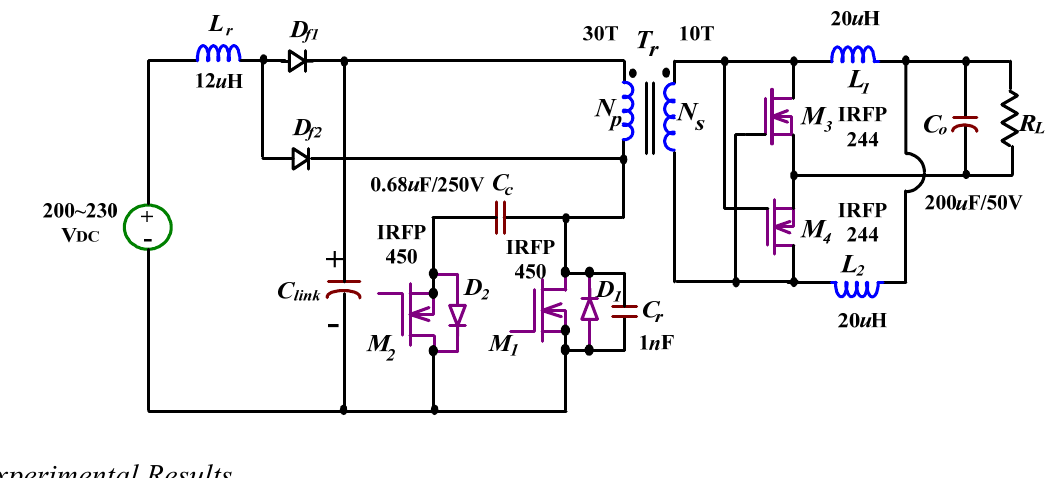
Figure 14. Experimental circuit of the proposed dual-input power supply